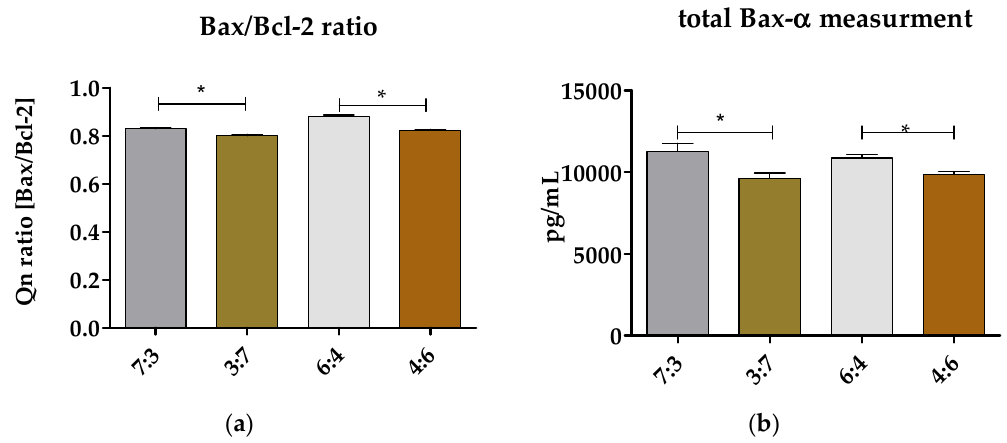
Figure 3. The analysis of Bax/Bcl-2 ratio ( a ) and total concentration of Bax- α ( b ). The transcripts levels were determined using RT-qPCR method, while total Bax- α was evaluated using ELISA technique. An asterisk was used to mark a statistically significant differences determined between tested groups (* p < 0.05).